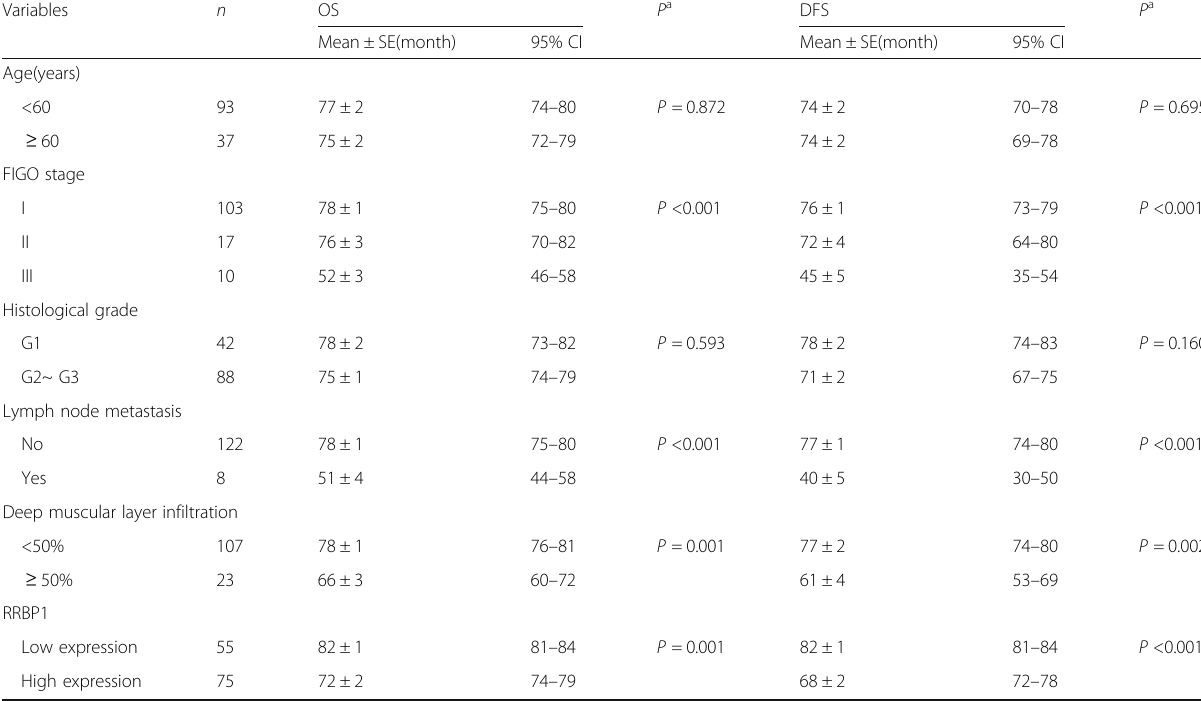
FIGO, International Federation of Gynecology and Obstetrics; G1, well differentiated; G2, moderately differentiated; G3, poorly differentiated; RRBP1, Ribosome-binding protein 1; OS, overall survival; DFS, disease-free survival; a Log-rank